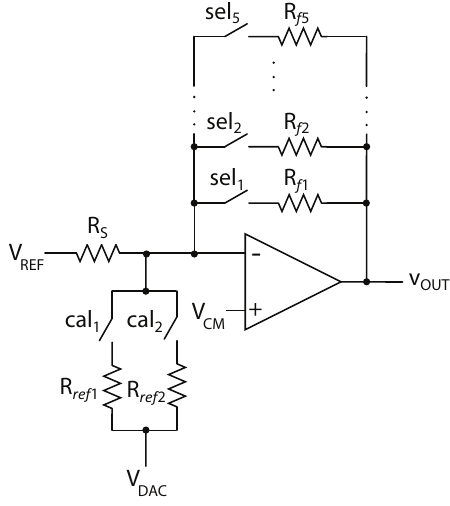
Figure 3. Front end readout